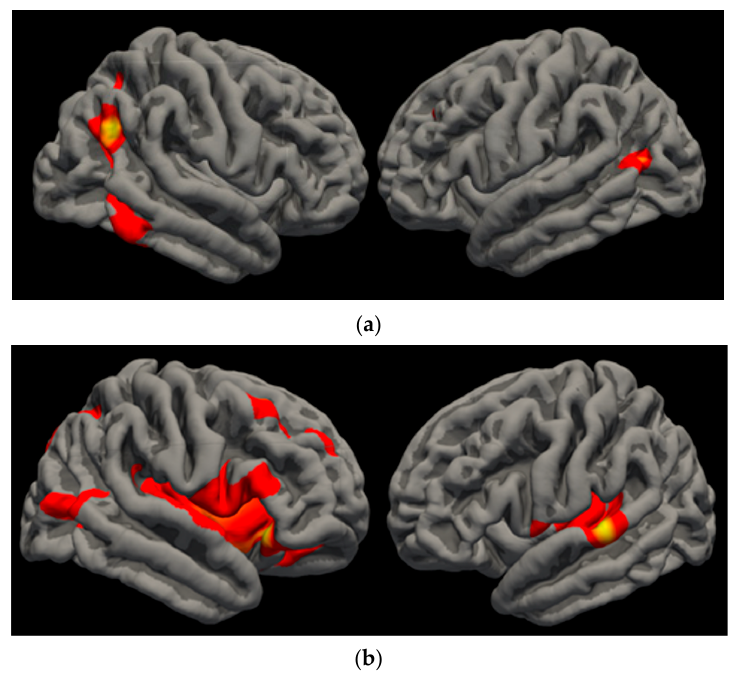
Figure 3. VO 2 Findings. ( a ) Lateral view of VO 2 finding observed in right inferior parietal, right inferior temporal, left superior parietal (not pictured), and left inferior parietal SA. Greater VO 2 was associated with more area in these regions. ( b ) Lateral view of VO 2 finding observed in right lateral orbitofrontal, right inferior parietal, and left superior temporal LGI. Greater VO 2 was associated with more gyrification in these regions.